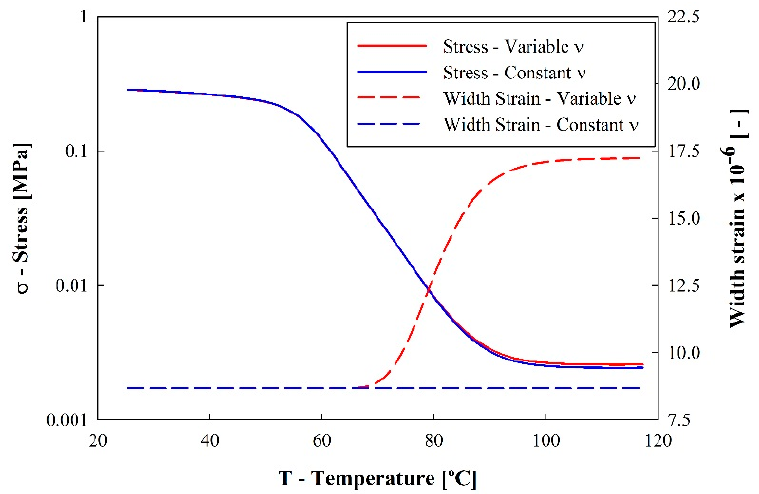
Figure 8. Comparison of results considering a constant and variable Poisson’s ratio.